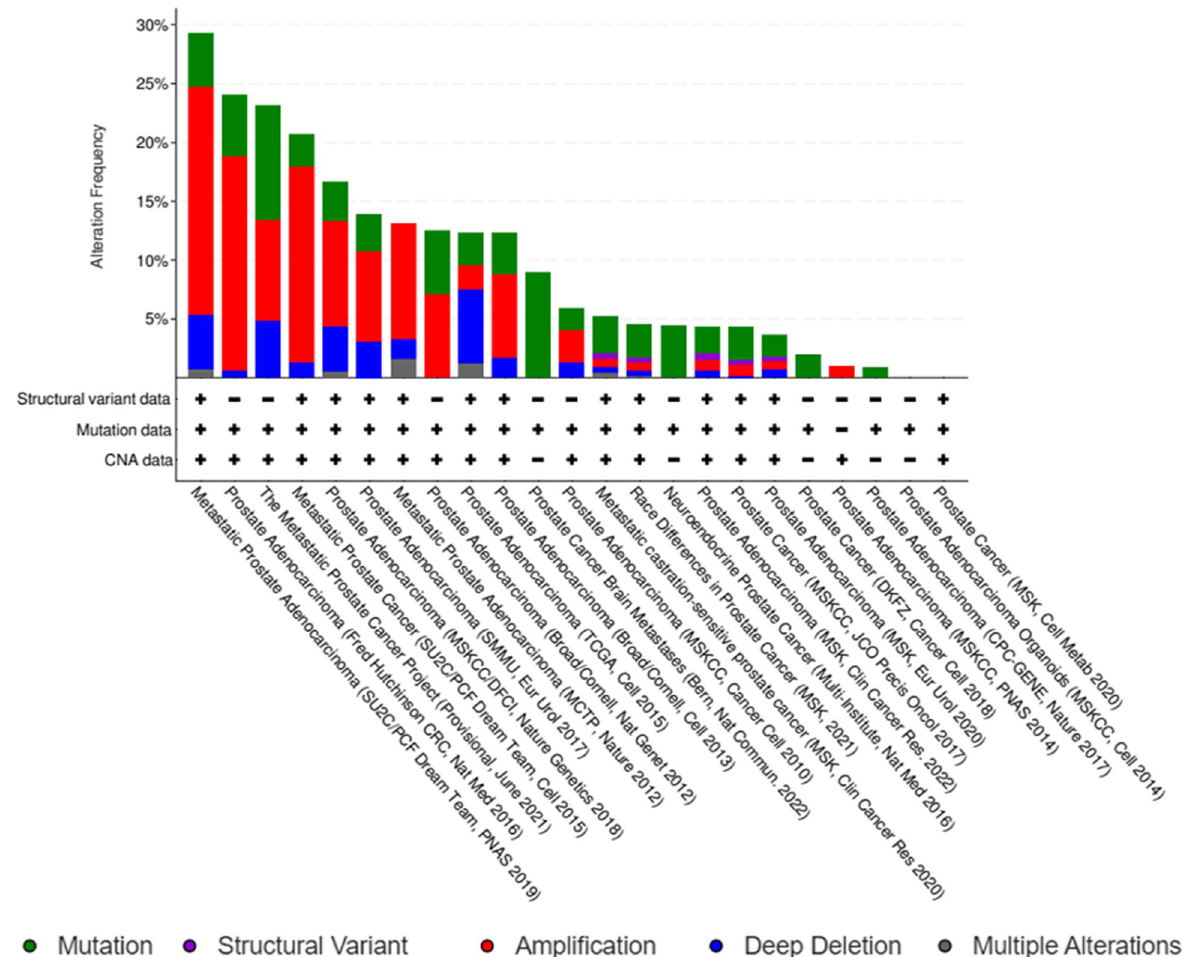
Fig. 4 Overview of the genetic alterations of the hub genes derived in this study across 23 PC studies. The different colours present in the bars represent the type of alteration present in each study and the legends are displayed at the lowest part of the plot; the name of each study is displayed are the base of the plot. The “ ” and “ - ” present at the base of the bar corresponds to the alteration data present in each study, with “ + corresponding to present and “ - ” corresponding to absent